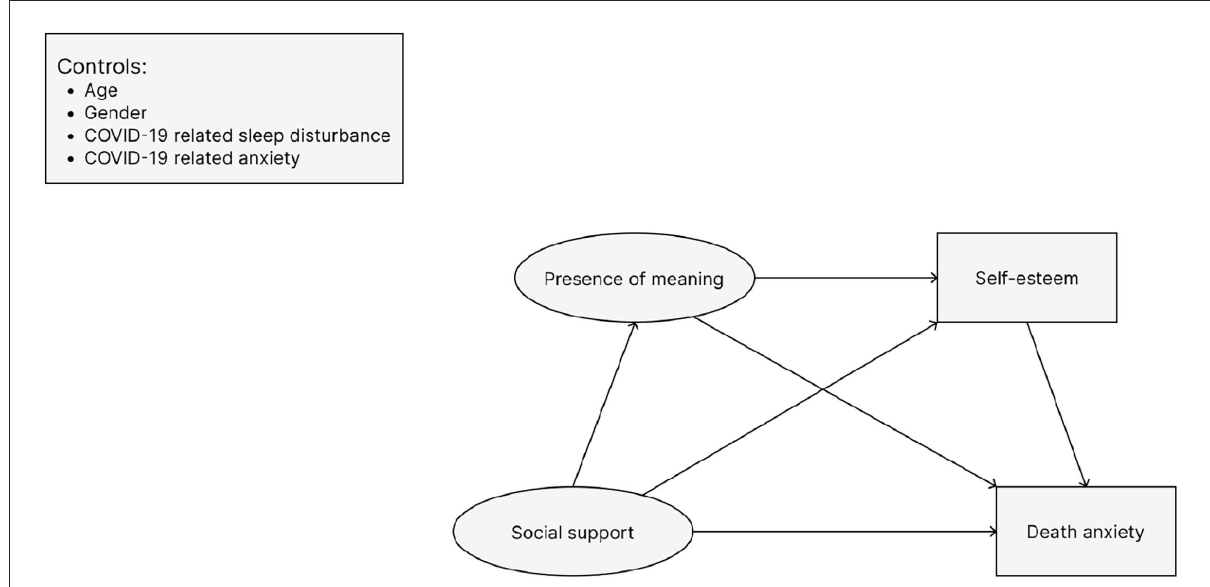
FIGURE1 Hypothesized structural equation modeling. Circles indicate latent variables, while rectangles represent observed